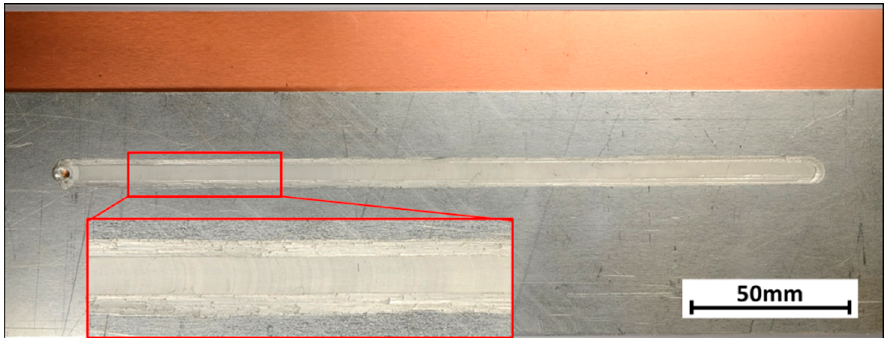
Figure 2. Illustration of the sample geometry.